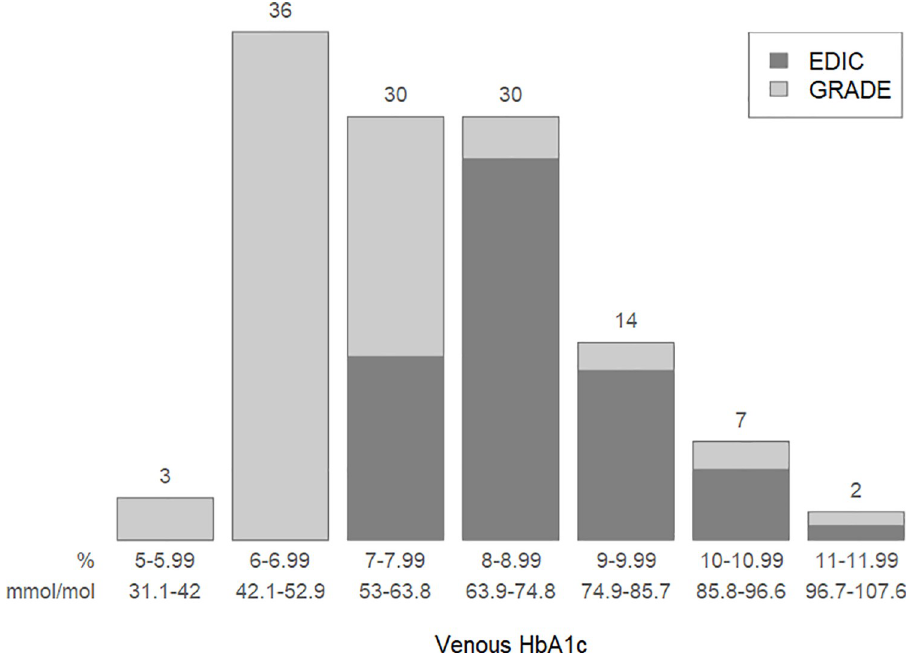
Fig 1. Distribution of HbA1c values from venous